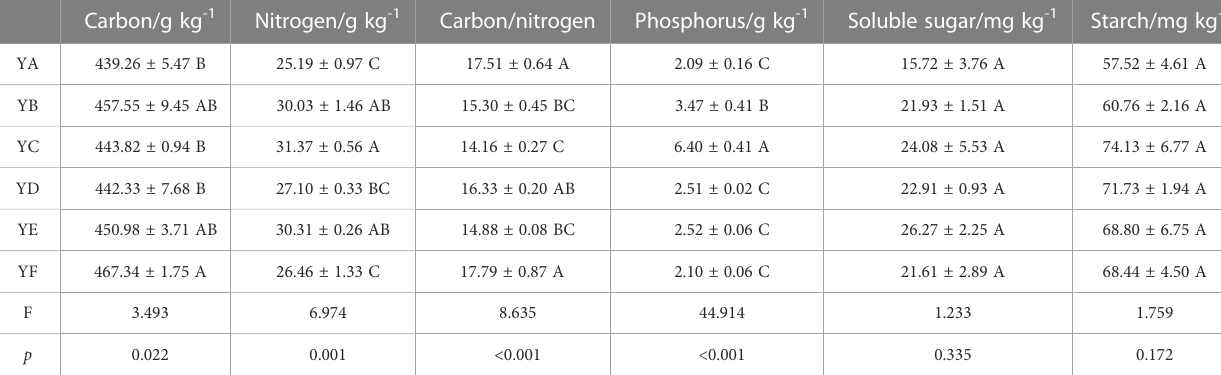
TABLE 1 Variation in the chemical properties of the leaves of different species of Populus